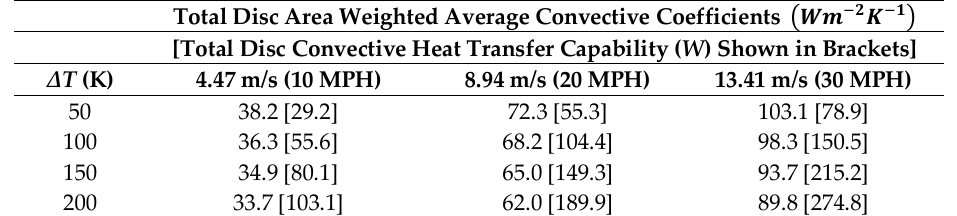
Table 1. Disc convective cooling coefficients and cooling power for various ∆(cid:1846) = (cid:1846) (cid:3031)(cid:3036)(cid:3046)(cid:3030) − (cid:1846) (cid:2998) and bike velocities. An 80 kg bicycle/rider descending an 8% grade at a steady 8.94 m/s requires a combined 559 W of energy dissipation from aerodynamic resistance, rolling resistance and wheel braking.